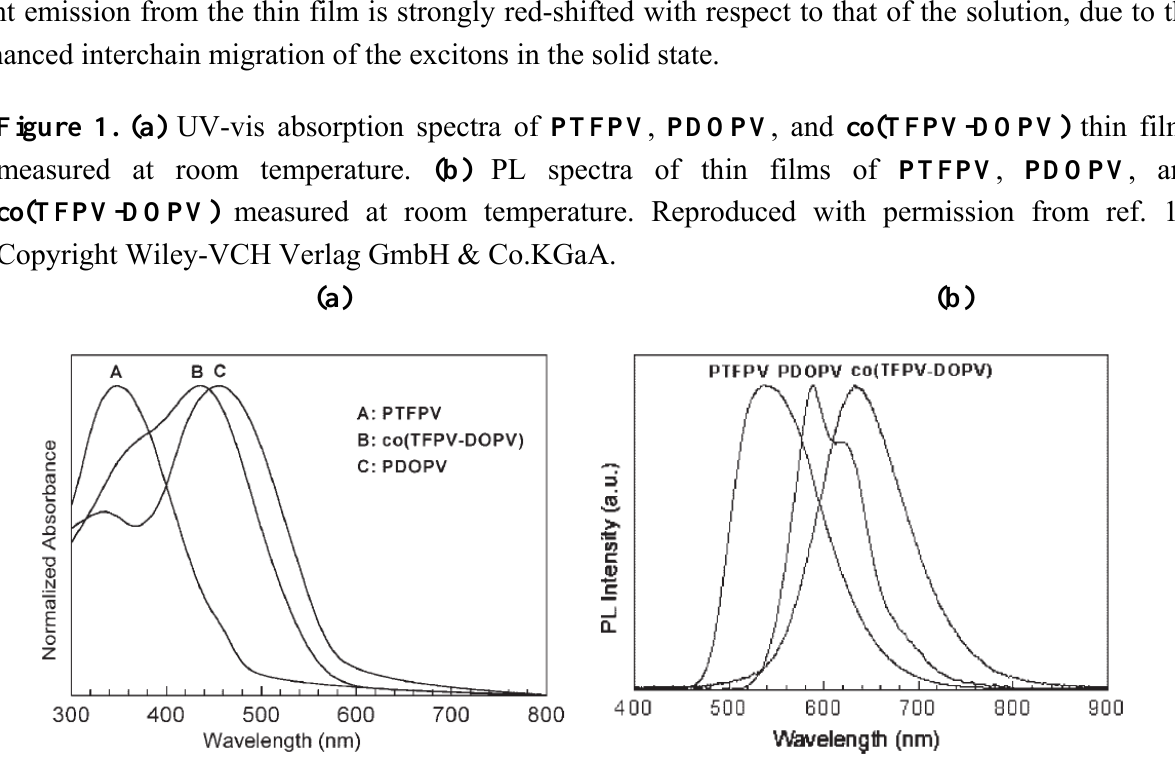
Figure 2. PL spectra of co(TFPV-DOPV) in solution (dotted line) and as a thin film (solid line) measured at room temperature. Reproduced with permission from ref.